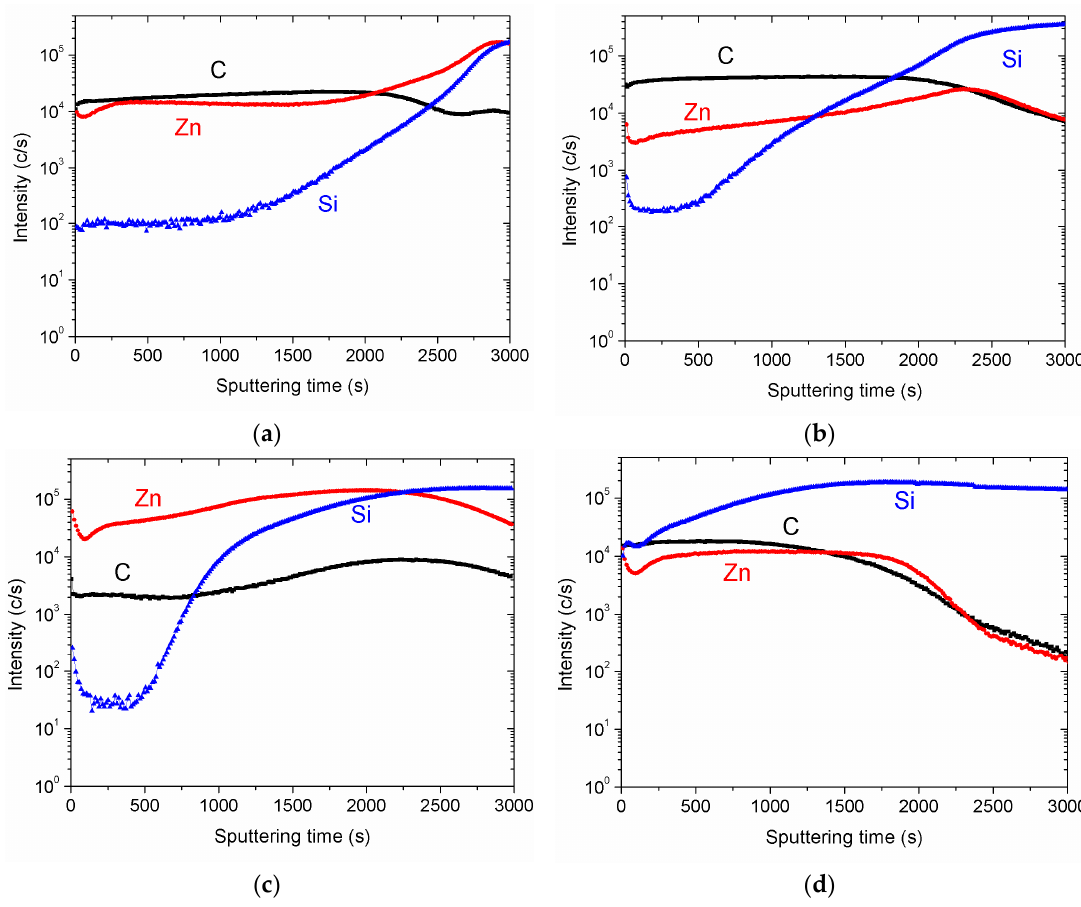
Figure 3. Secondary ion mass spectrometry (SIMS) depth profiles of Zn-DLC samples, showing the signals 12 C, 30 Si and 64 Zn ( a ) 9.6 at.% Zn, as prepared; ( b ) 9.6 at.% Zn, etched; ( c ) 38.9 at.% Zn, as prepared; ( d ) 38.9 at.% Zn, etched.